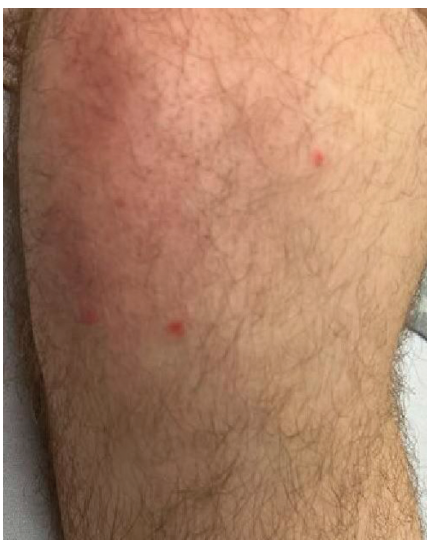
Figure 9: Resolving lesions on left arm involving lesion post-